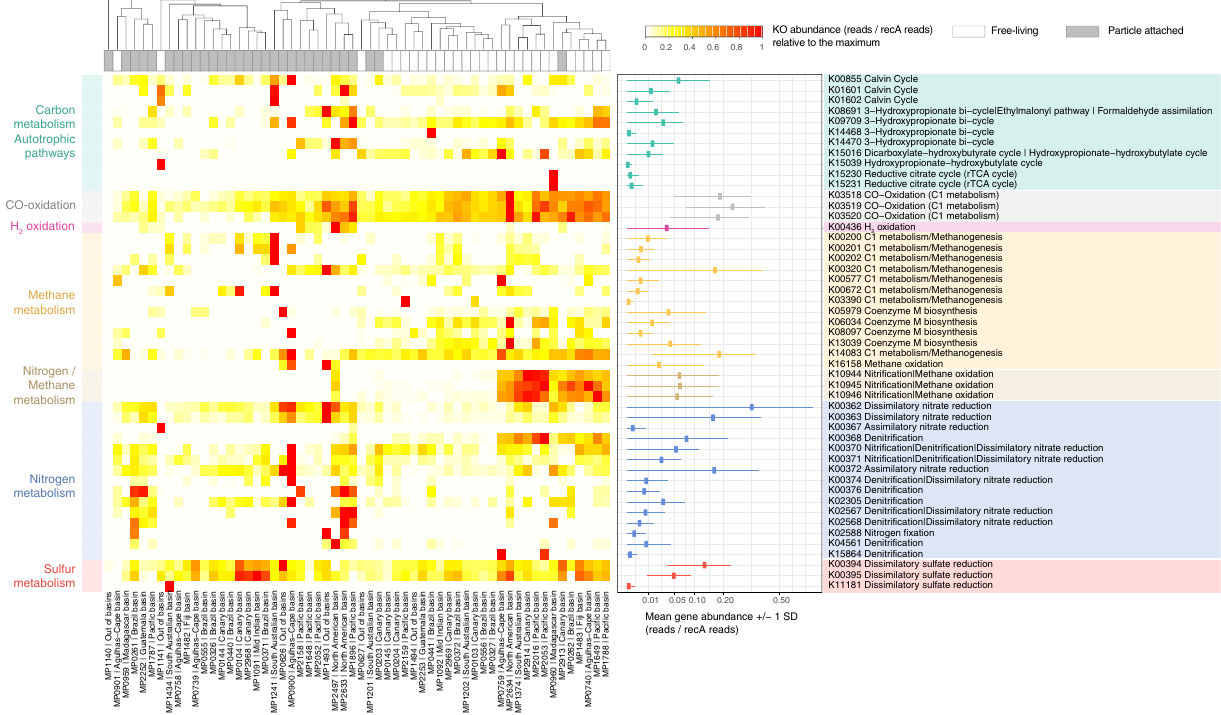
Fig. 3 Heatmap of selected marker genes for different metabolic pathways across the 58 metagenomes. A total of 49 marker genes (KOs, Y